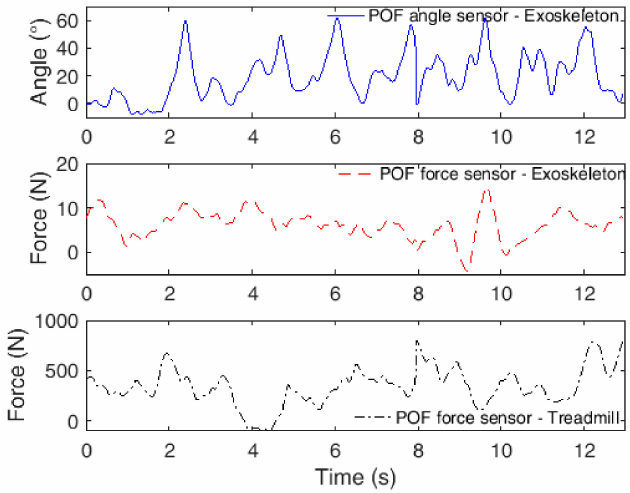
Figure 7. POF sensor responses in robot-assisted rehabilitation using an exoskeleton as a gait assistance